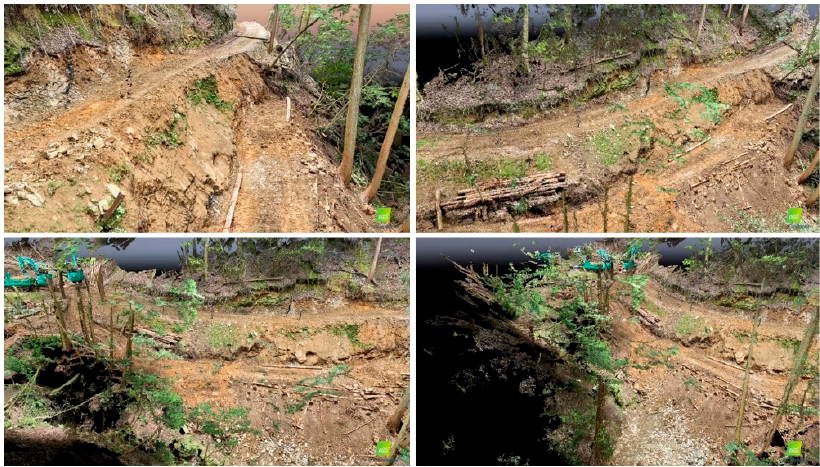
Figure 2. A 3D model generated by SfM analysis during the repair work.